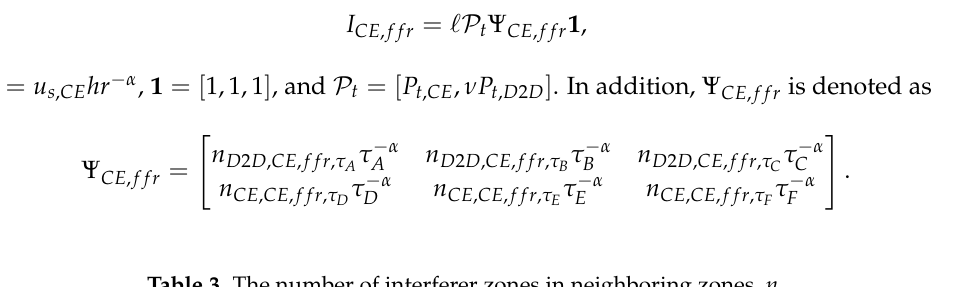
Table 3. The number of interferer zones in neighboring zones, n